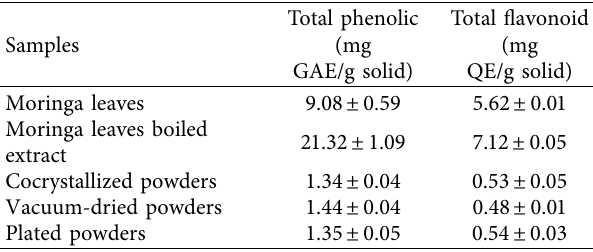
Table 2: Colour attributes of moringa leaves extract powders. Samples